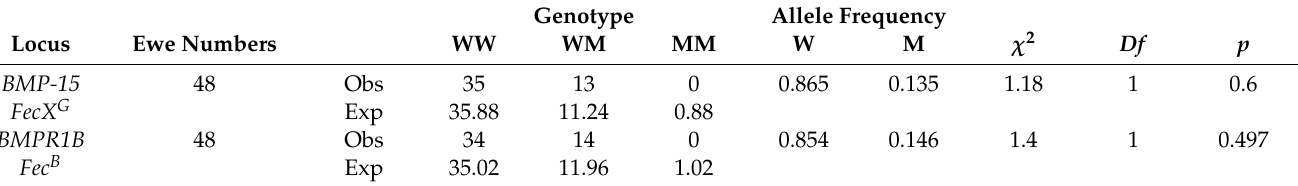
Table 4. Characteristics of the BMP-15 ( FecX G ) and BMPR1B ( Fec B ) loci in Romanov ewes (n = 48). Genotype Allele